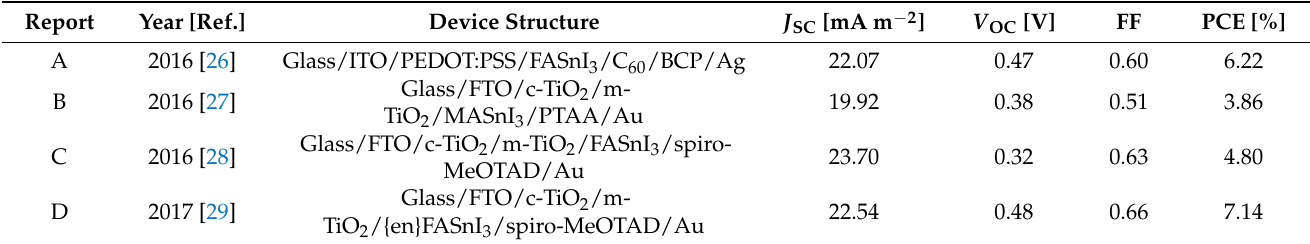
Table 1. Record table containing the reported Sn-PSCs and the corresponding photovoltaic parameters mentioned in Section 2.1. Report